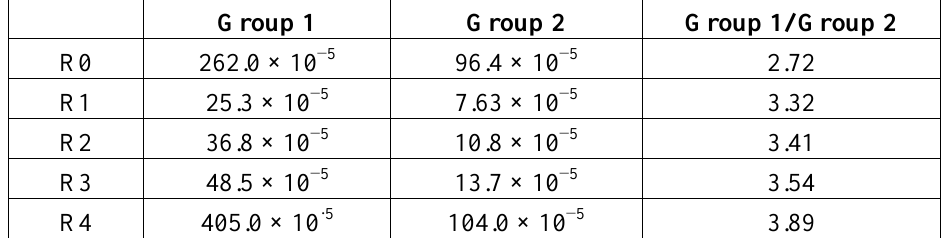
Table 3. The results of estimating skin cancer risk (average risk from 10,000 permutations) for 2 groups based on the